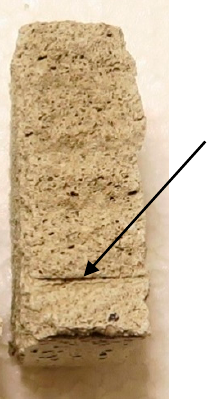
Figure 9. Transversally broken part of print object (not specimen) to show voids around cable shaft.